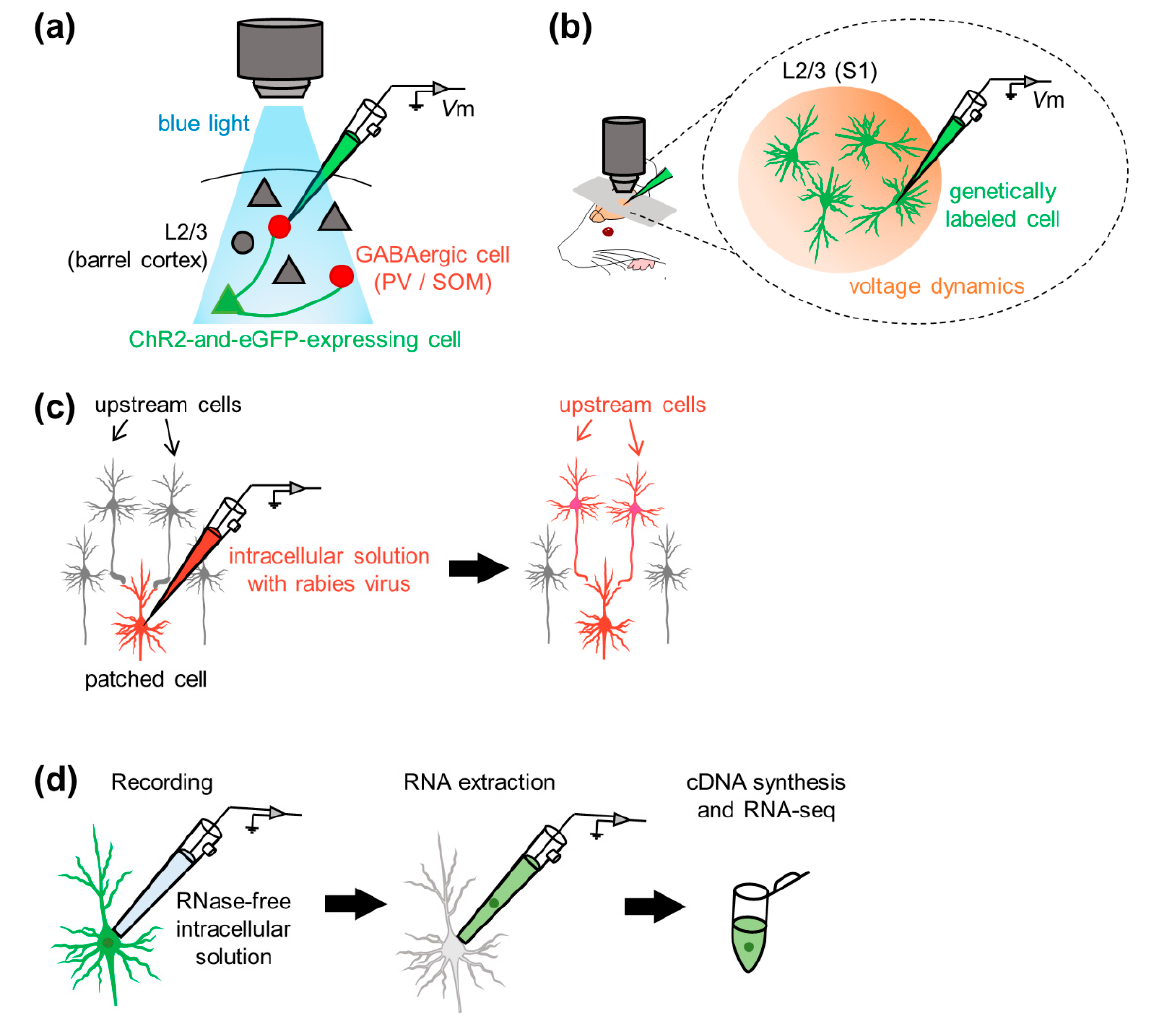
Figure 5. Examples of combinations of in vivo whole-cell recordings with other techniques. ( a ) Channelrhodopsin 2 and eGFP are artificially expressed in specific excitatory cells ( green , triangle ) in layer 2/3 of the barrel cortex. Whole-cell recordings are made from PV-positive or SOM-positive GABAergic cells ( red , circle ), and light-induced membrane potential fluctuations of GABAergic neurons are recorded. ( b ) Whole-cell recordings are made from neurons in layer 2/3 of the somatosensory cortex. Membrane potential fluctuations of surrounding neurons are simultaneously recorded using the voltage-sensitive dye. ( c ) Whole-cell configurations are made using the intracellular solution with the rabies virus. After recording, presynaptic (upstream) neurons are traced with the aid of the virus. ( d ) Whole-cell recordings are made using RNase-free intracellular solution. After recording, the cell content is extracted through the patch pipette. Subsequently, RNA sequencing is performed. Abbreviations : V m, membrane potential; ChR2, channelrhodopsin 2; eGFP, enhanced green fluorescent protein; PV, parvalbumin; SOM, somatostatin; S1, primary somatosensory